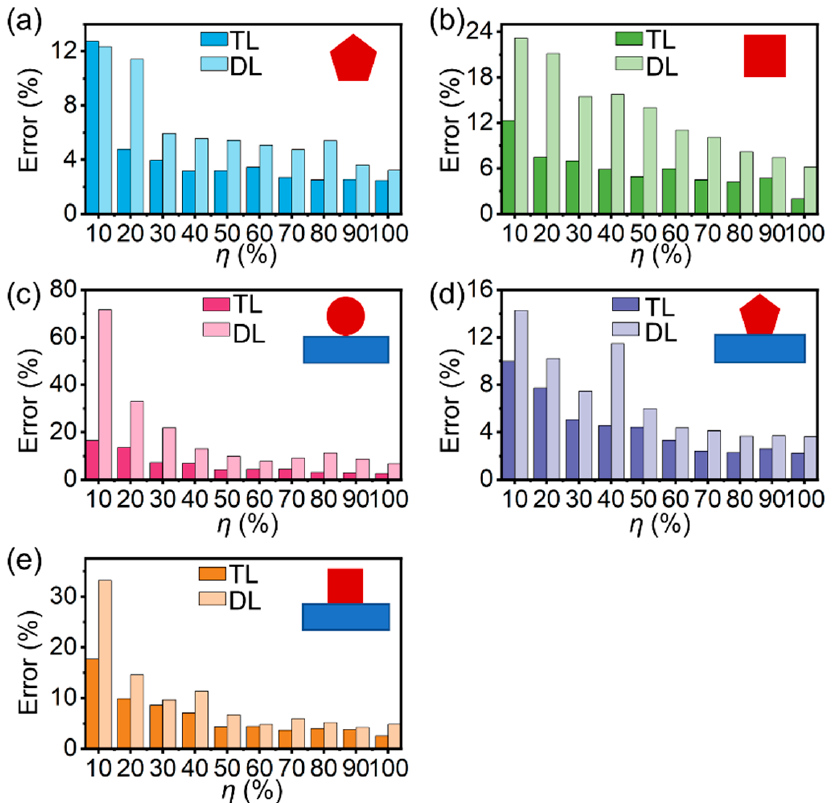
Figure 5. Reduced training dataset size enabled by transfer learning. Comparison of average errors between transfer learning and direct learning using different portions ( η ) of the training dataset for ( a ) free-stranding pentagonal MNWs, ( b ) free-standing square MNWs, ( c ) substrate-supported circular MNWs, ( d ) substrate-supported pentagonal MNWs, and ( e ) substrate-supported square MNWs. Insets: schematic illustrations of the geometries of MNWs with different configurations.